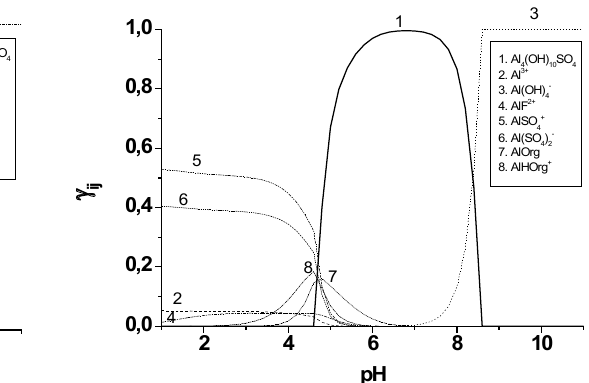
Figure 8. Distribution curves of the soluble species and solid phase in the system „basaluminite – saturated aqueous solution” for